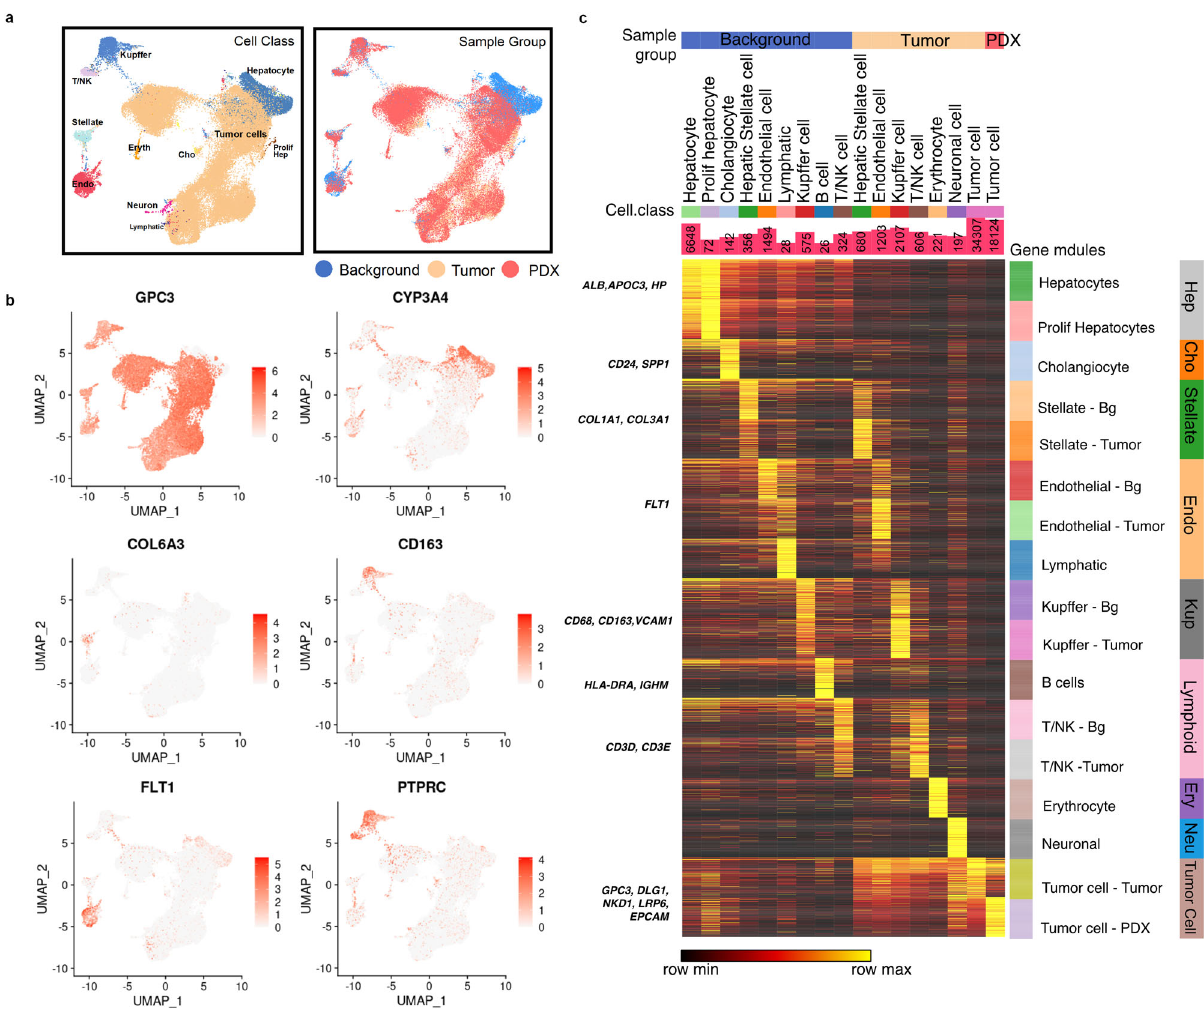
Fig. 3 Single-cell RNA sequencing characterization of background liver, tumor, and PDX. a UMAP of cell classes (Left) and sample groups (Right) of the integrated data from background, tumor and PDX. Endo endothelial cell, Stellate hepatic stellate cell, Eryth erythrocyte, T/NK 774 T cell or NK cell, Cho cholangiocyte, Prolif Hep proliferative hepatocyte. b Marker genes for common cell populations in liver and tumor were drawn on UMAP. DLK1 shows tumor, HPGD identi fi es hepatocytes, FLT1 indicates epithelial cells, COL6A3 represents hepatic stellate cells, CD163 marks Kupffer cells, and PTPRC indicates immune cells. c The heatmap for 200 most upregulated genes for cell types within background liver, tumor, and PDX (Methods). Known markers were shown on the left. Cell counts are shown in bar